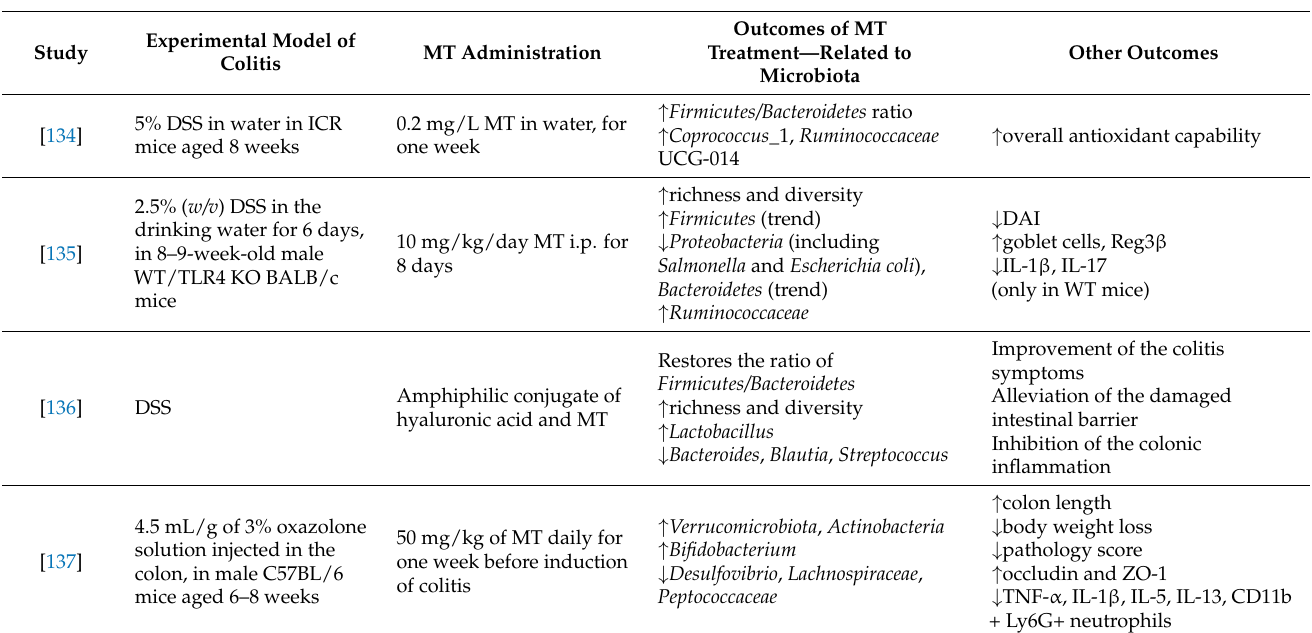
Table 1. Evidence from clinical and preclinical studies supporting the role of MT in IBD, in relation to the gut